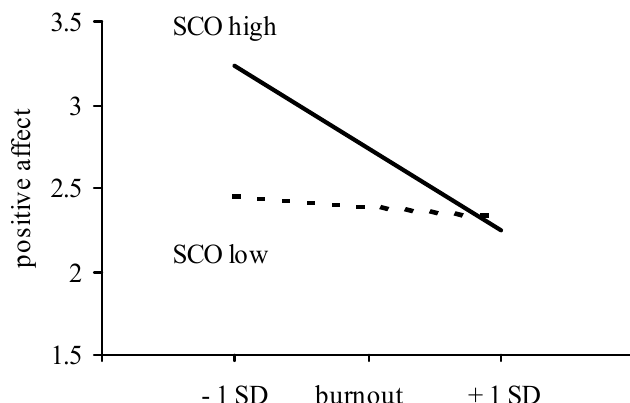
Figure 4. Positive affect after upward comparison as a function of burnout and SCO [13].